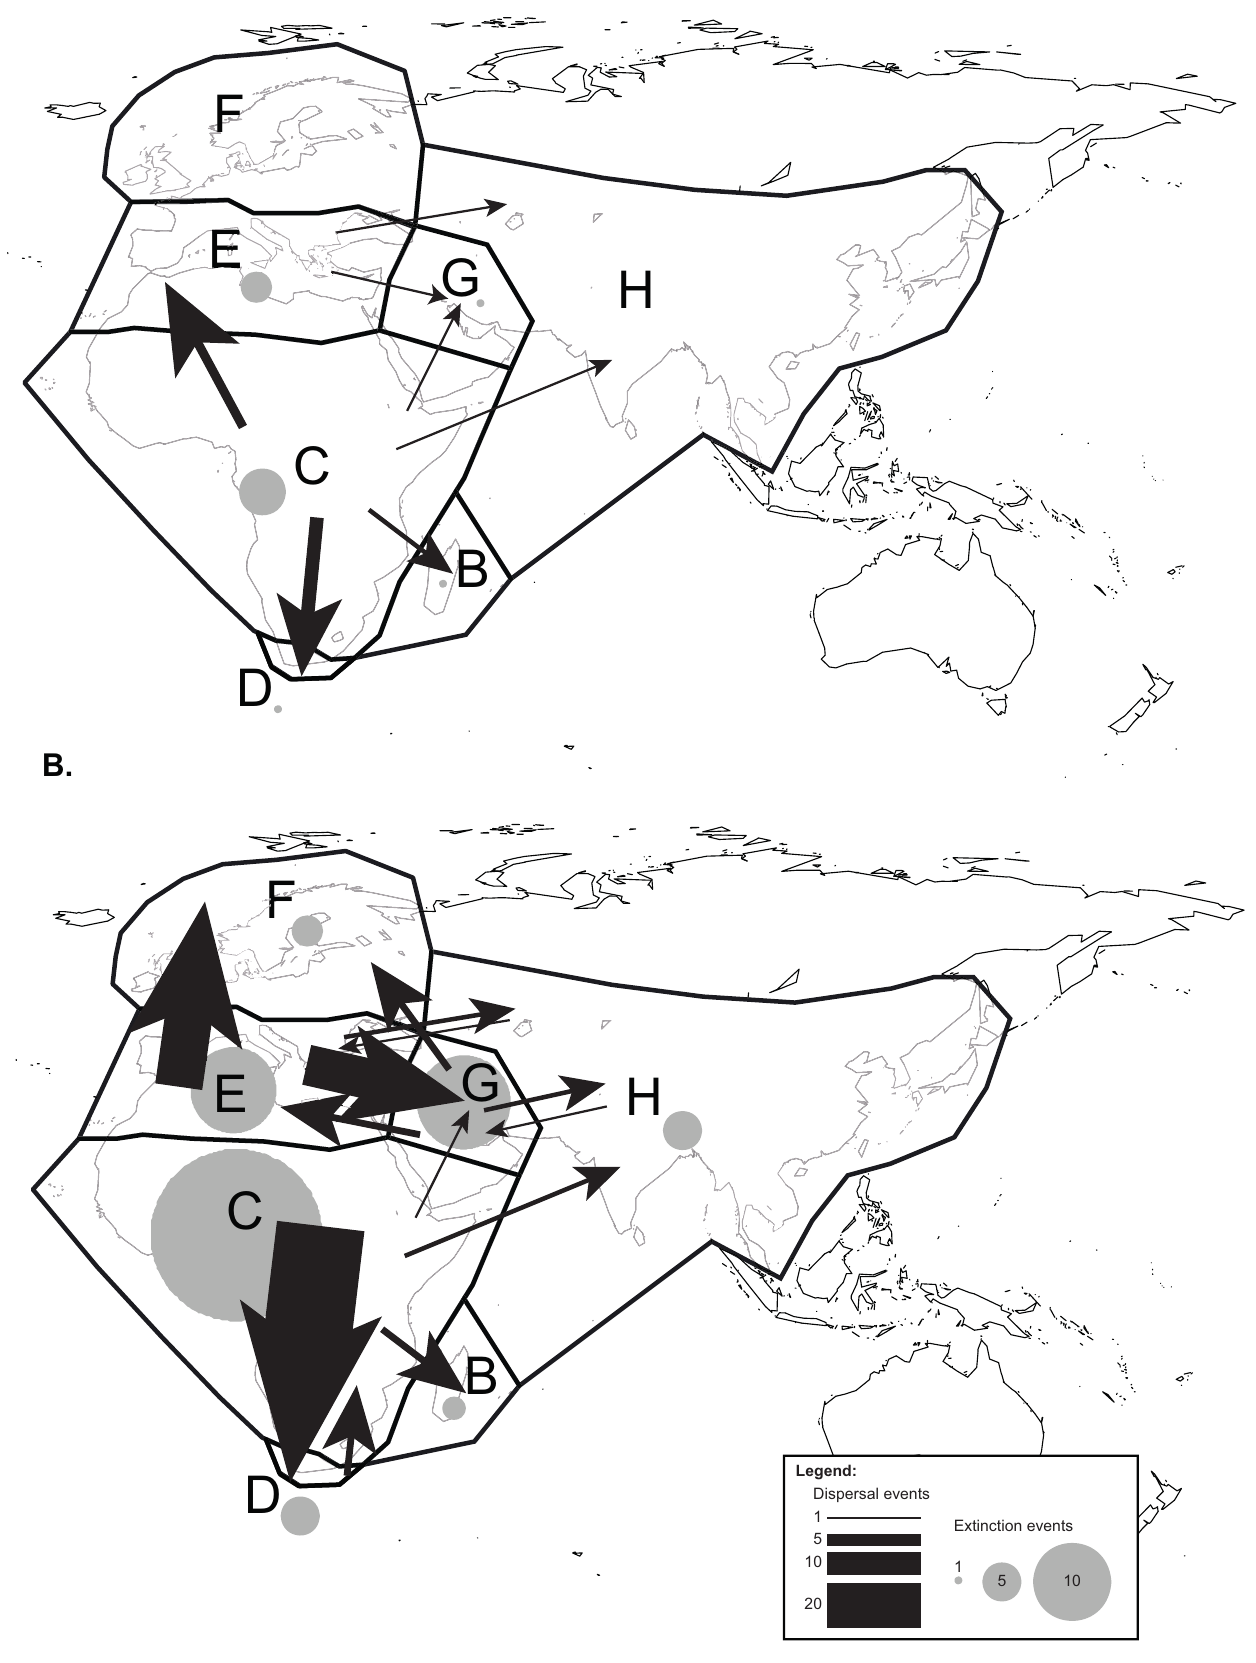
10Extinction events